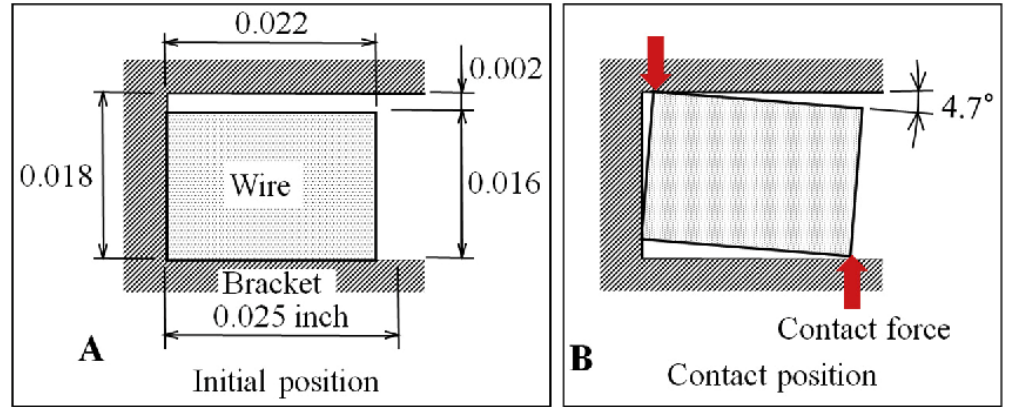
Figure 8. The archwire position in the brackets slot: an initial position ( A ), maximum wire displacement and contact points—greatest abrasive wear areas ( B ) [111].